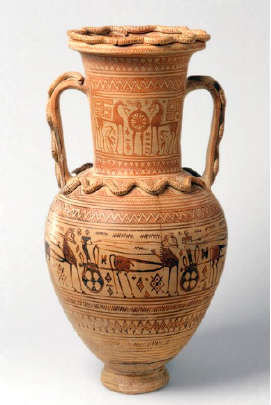
Figure 7. Funerary vase with martial scenes and snake appliques (MMA acc. no. 10.210.7); neck- amphora, ceramic; Attica; Geometric, ca. 725–700 BCE . [Image courtesy of the open-access program of the Metropolitan Museum of Art, New York]. Half a dozen Attic black-figure vases (dated ca. 550–450 BCE ) depict Achilles’ dragging of Hektor’s body around the city of Troy (Figure 8). 63 They show Patroklos’ funerary tumulus , usually painted white, with a snake on or near it, and the eid¯olon 64 flying around. Eva Grabow (1998, p. 156) puts the snake on these vases in relation to hypothetical real statues that would have been placed next to the tomb, but this interpretation is problematic.